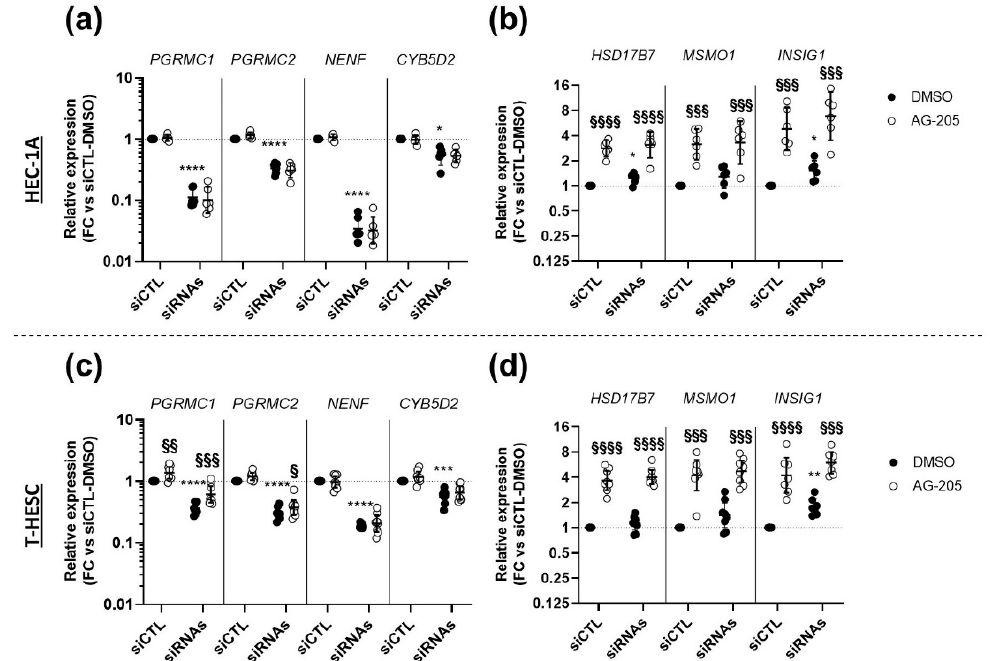
Figure 8. Effect of AG-205 on expression of selected target genes is not modified upon combined siRNA-mediated down-regulation of PGRMC1, PGRMC2, NENF and CYB5D2 expression. HEC-1A ( a , b ) or T-HESC cells ( c , d ) were transfected with a combination of 2 nM siRNA-PGRMC1 s21310, 2 nM siRNA-PGRMC1 18248, 2 nM siRNA-PGRMC2, 2 nM siRNA-NENF and 2 nM siRNA-CYB5D2 (siRNAs) or 6 pmol control siRNA-CTL (siCTL) during 48 h. They were then further incubated for 32 h with 15 µM AG-205 or DMSO. Relative expression of PGRMC1, PGRMC2, NENF and CYB5D2 ( a , c ) and HSD17B7, MSMO1 and INSIG1 ( b , d ) was measured by RT-qPCR ( n = 6 – 8), normalized, compared to dual control values (siCTL with DMSO) and is presented as individual fold changes (FC) in log or log2 scale and as geometric means with geometric SD. Statistical test: Anova-two ways with post-hoc Tukey. Statistically significant differences resulting from siPGRMC1 transfection or AG205 addition are indicated by * or §, respectively: */§ p < 0.05, **/§§ p < 0.01, ***/§§§ p < 0.001, ****/§§§§ p < 0.0001.